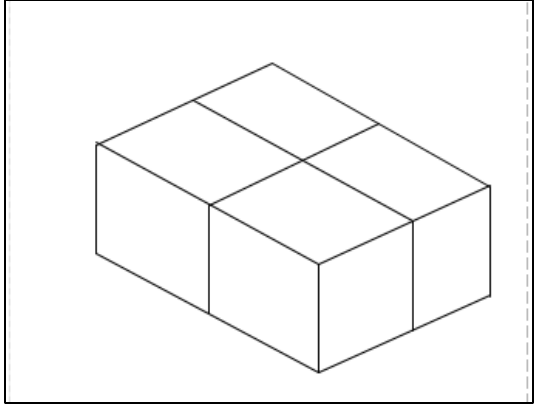
Figure 3. Life jacket stacking model.